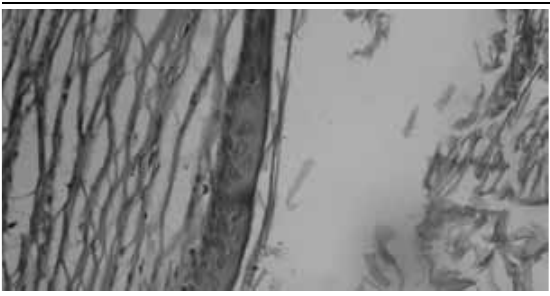
HE: hematoxylin and